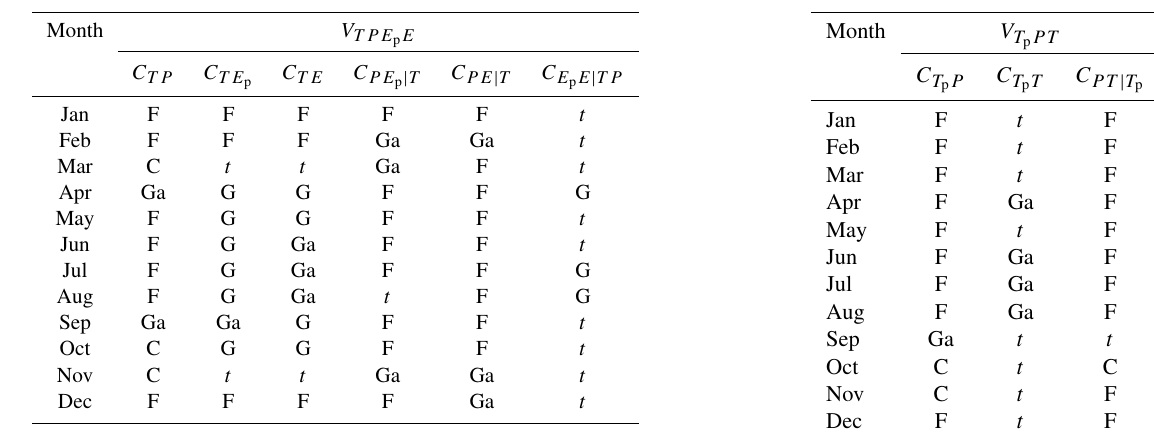
Table 1. Bivariate copula families selected by AIC for V TPE where F stands for Frank, Ga for Gaussian, G for Gumbel, C for Clayton, J for Joe and t for t -copula family.